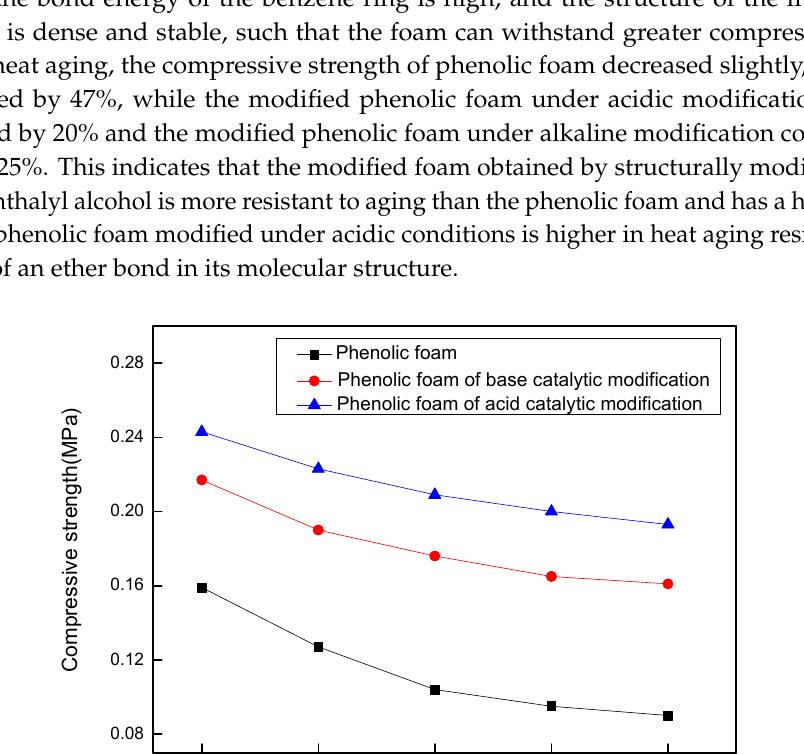
Table 4. Schematic diagram of heat aging color change of modified phenolic foam.